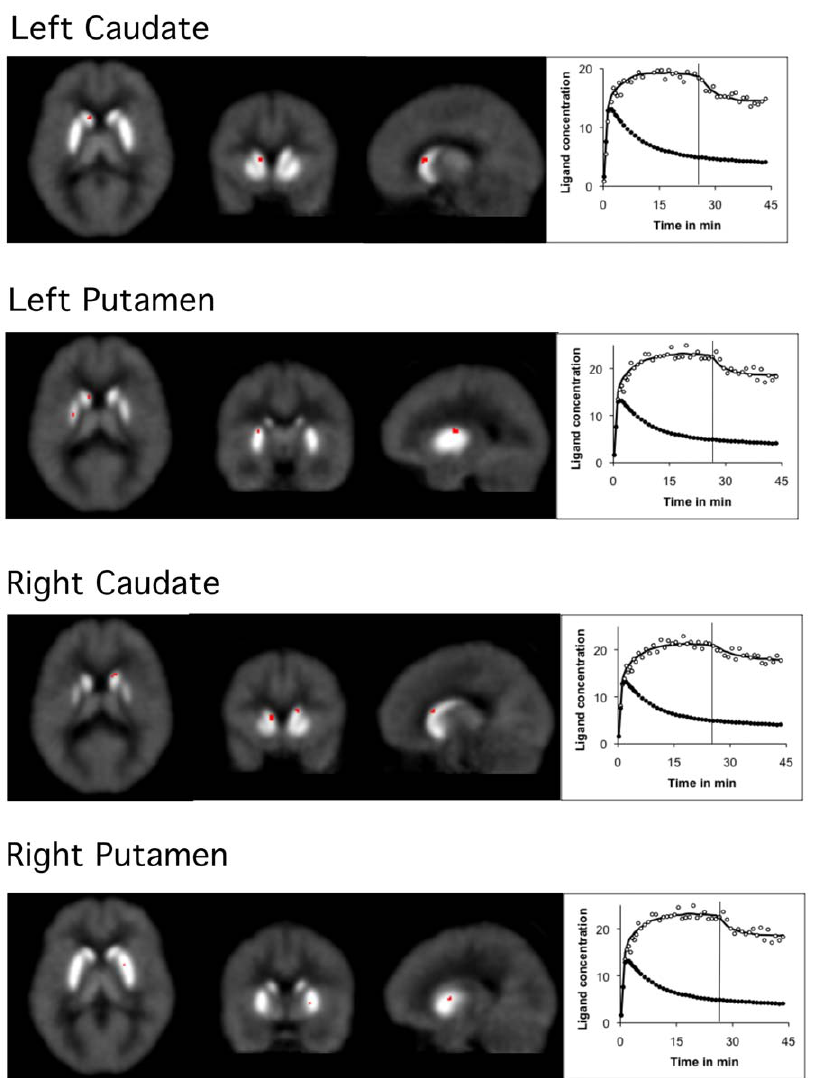
Figure 1. t-maps and time-activity curves showing changes in the rate of ligand dissociation during task performance. The striatal areas where rate of ligand displacement increased significantly in the Incongruent condition of the flanker task are shown on the t-maps. The most significant increase was observed on the dorsal aspect of the body of left caudate. The time-activity curves show the ligand concentration (open circles) and least square fit (solid lines) in a striatal area (upper curve) and in the reference region (lower curves). The data on the left of the vertical lines were acquired in the Congruent condition and those on the right were obtained in the Incongruent condition. Significant reduction in the ligand concentration in the Incongruent condition suggests that the rate of ligand displacement increased during task performance. The increase was due to competitive displacement induced by endogenously released dopamine. There was no significant change in the rate of ligand displacement in the reference region (cerebellum). The time-activity curves were drawn using the mean data acquired from the voxels where maximum changes were observed in each area. This analysis used the linear extension of reference region tissue model (LE-SRRM).